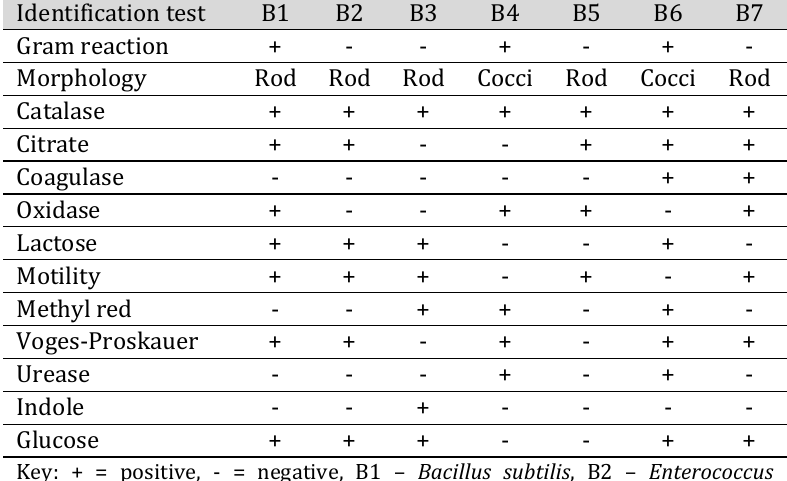
Key: + = positive, - = negative, B1 –